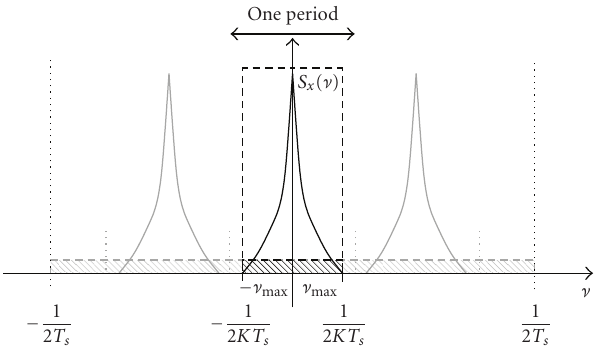
Figure 2: Principle of low-pass filtering to obtain a low-noise sequence. The ideal low-pass filter adapted to the signal covers the frequency band ] − ν max , ν max [ (black dashed). The shaded area indicates the noise power density. Light shaded indicates masked out noise; whereas dark shaded indicates the noise in the frequency band of the signal. The light shaded spectra are repetitions of the spectrum of the signal due to